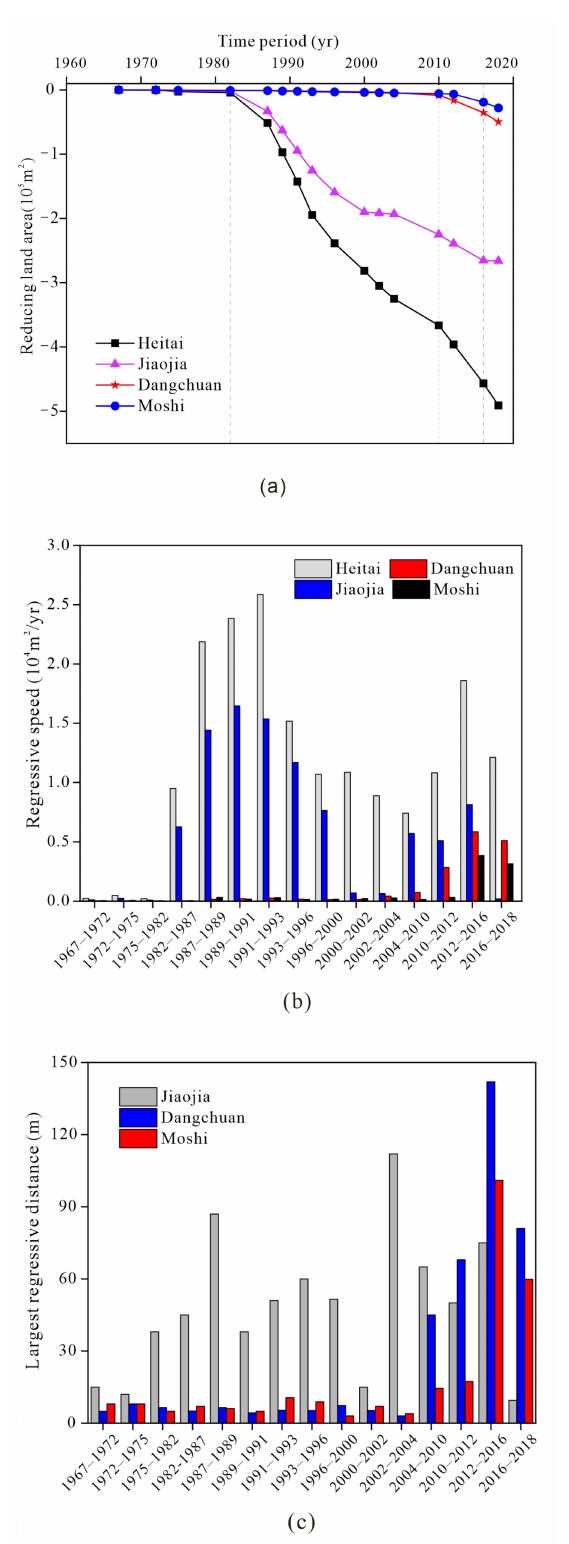
Figure 3. Evolution characteristics of tableland edge. ( a ) Degradation area; ( b ) degradation speed; ( c ) maximum degradation distance.